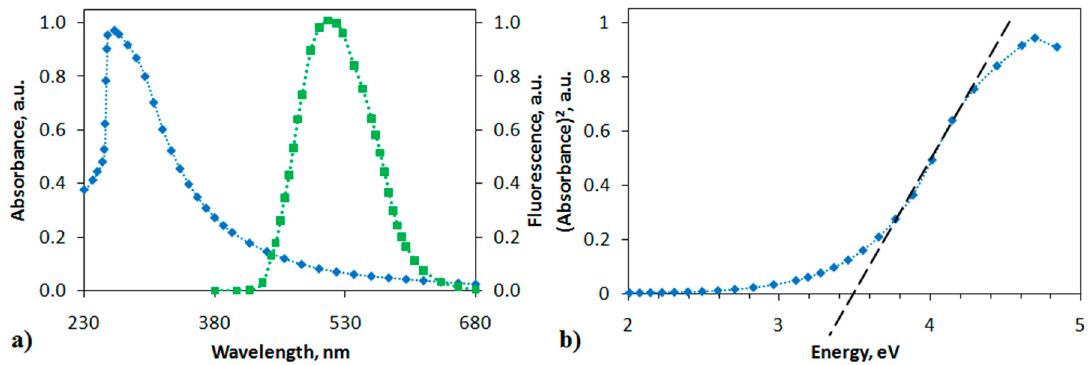
Figure 3. ( a ) Absorption (blue curve) and photoluminescence (green curve) spectra of MPIn, ( b ) dependence of α 2 on photon energy h ν .